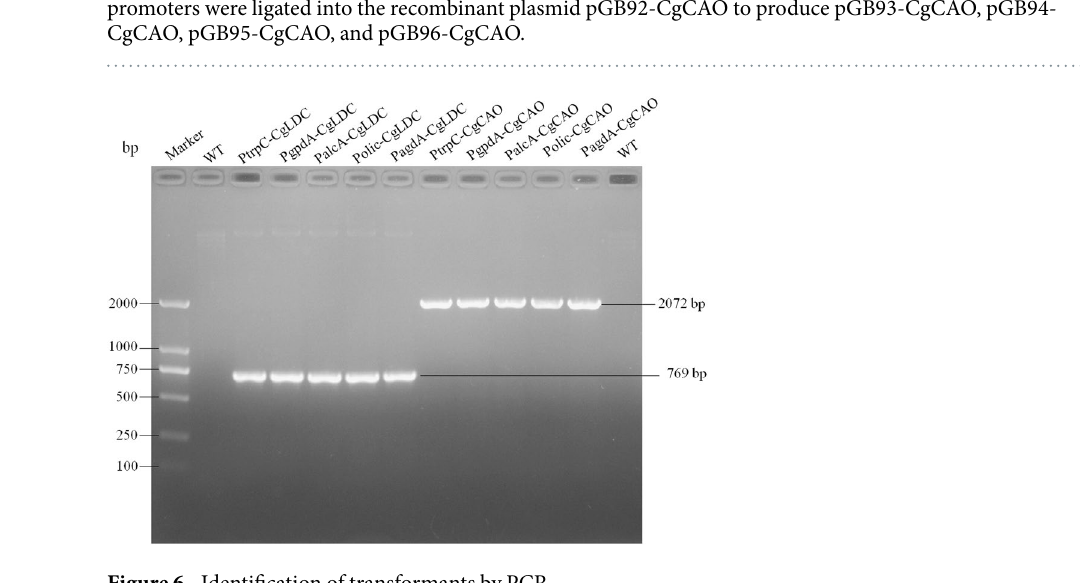
Figure 6. Identification of transformants by